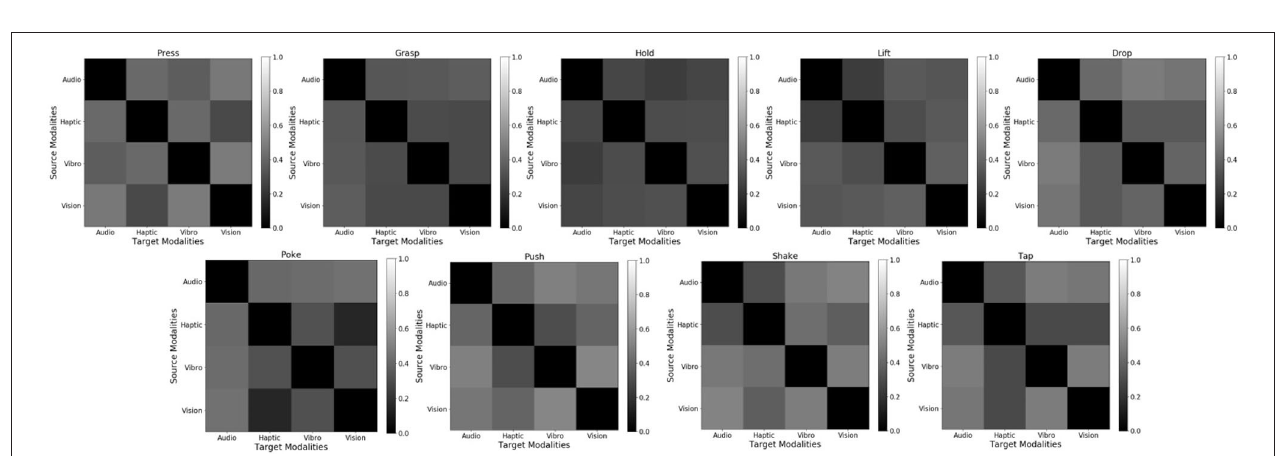
FIGURE 11 | Two sources β -VAE cross-perception projections where the recognition accuracy improves as compared with corresponding β -VED projections.